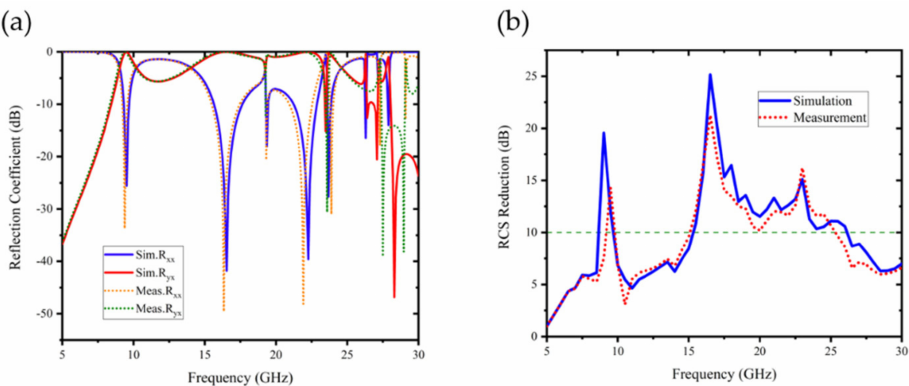
Figure 12. Comparison of measured and simulated results. ( a ) Measured and simulated reflection coefficients. ( b ) Measured and simulated RCS